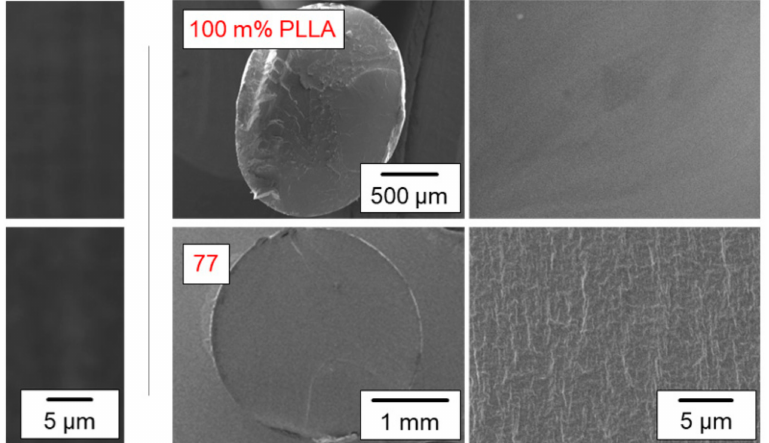
Figure 2. Morphology of extruded strands of neat PLLA ( top images) and of a PLLA/IR3535 mixture containing 23 m% IR3535 ( bottom ), as observed by POM ( left ) and SEM ( right ), respectively, at different magnifications. The POM images were obtained from the central part of thin sections taken perpendicular to the extrusion direction of the strands with a diameter of about 2 mm, and the SEM images were obtained from cross-sections of cryo-fractured strands coated by gold, providing an overview and details of the structure. The PLLA/IR3535 extrudates for POM and SEM measurements were stored at room temperature for 3 weeks and 7–8 weeks,